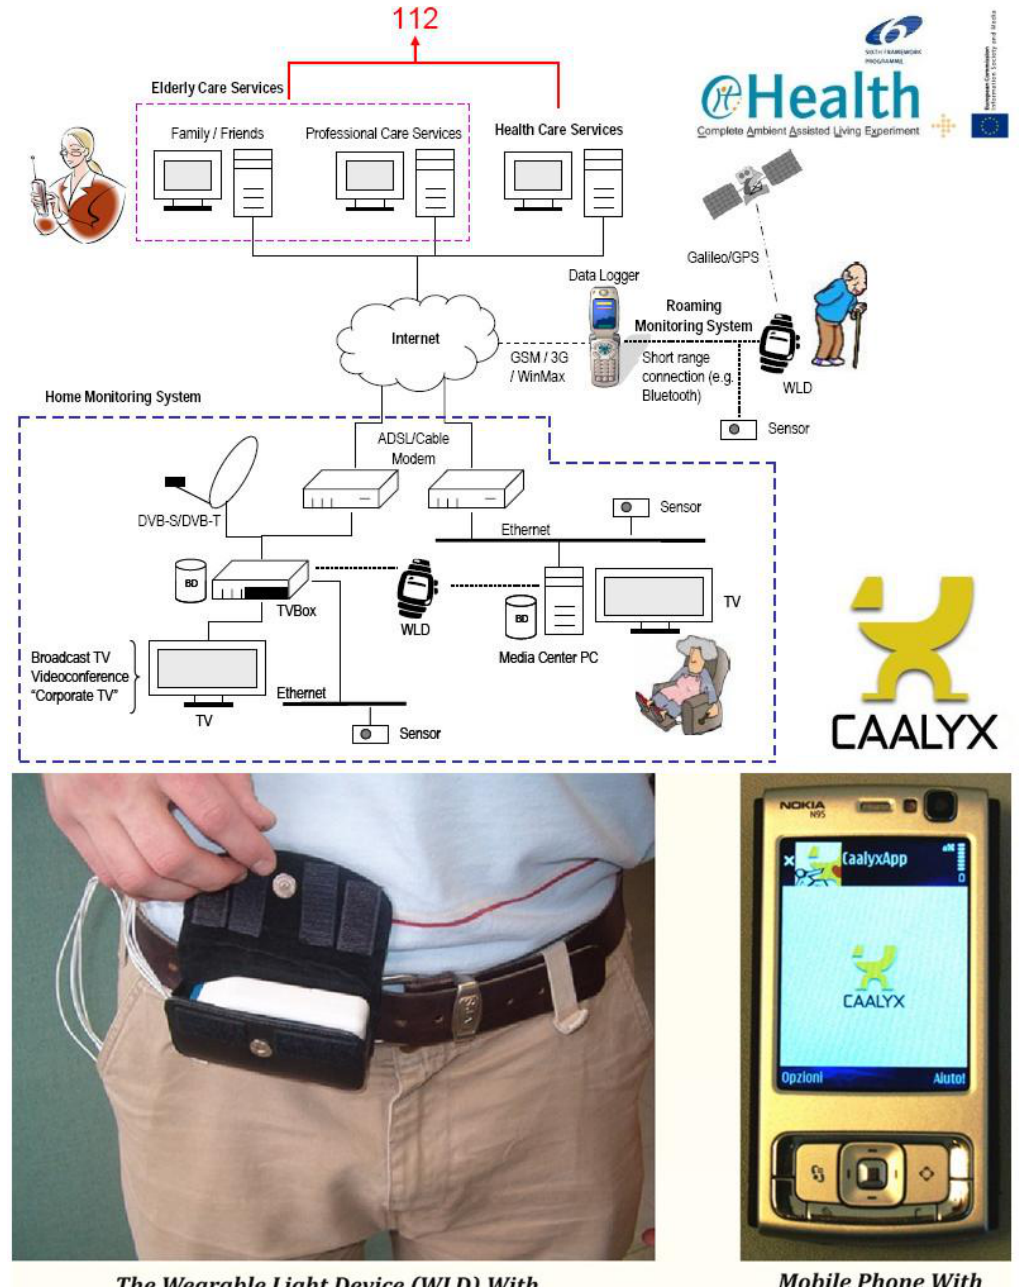
Figure 1. CAALYX‘s system diagram. In the final system prototype presented in March 2009, the WLD (Wearable Light Device) takes the form of a waist-belt mounted device that communicates with a mobile phone (data logger) running the CAALYX